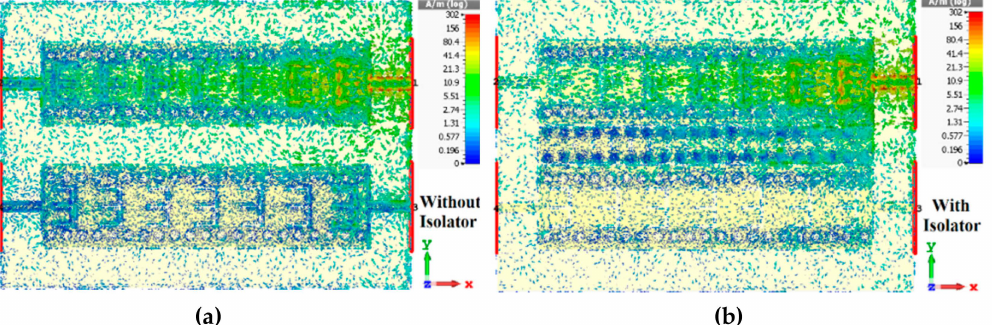
Figure 8. Surface current density distributions without and with the metamaterial shield at 60 GHz. ( a ) without the metamaterial shield; ( b ) with the metamaterial